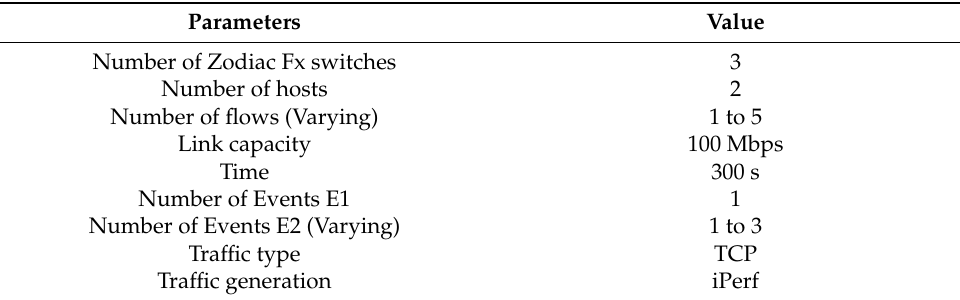
Figure 15. Real-world test bed. Table 4. Experimental